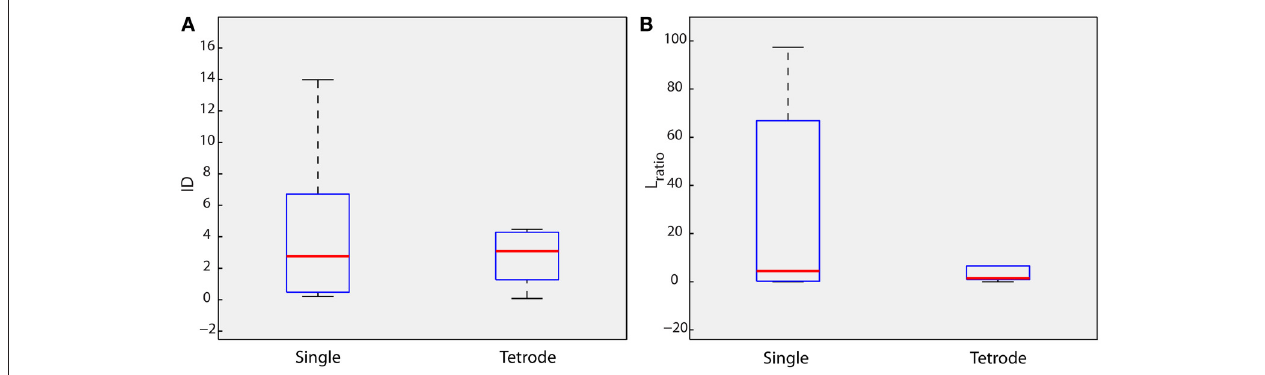
FIGURE 4 | Tetrode signals. L ratio and Isolation Distance (ID) values estimated for the cluster of the intracellularly recorded neuron, for all 10 datasets of real data, when D w is estimated using only one electrode (single electrode) and four electrodes (tetrode). (A) ID (B) L ratio